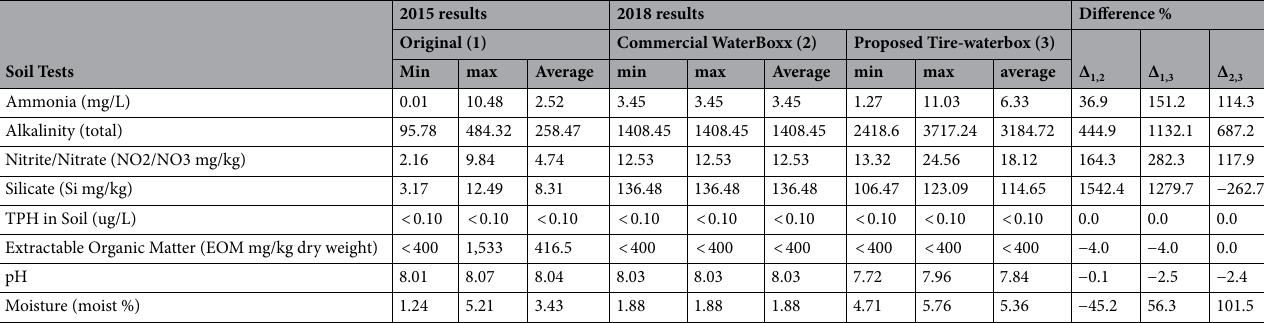
Table 12. Summary of soil test results of original and new designs.